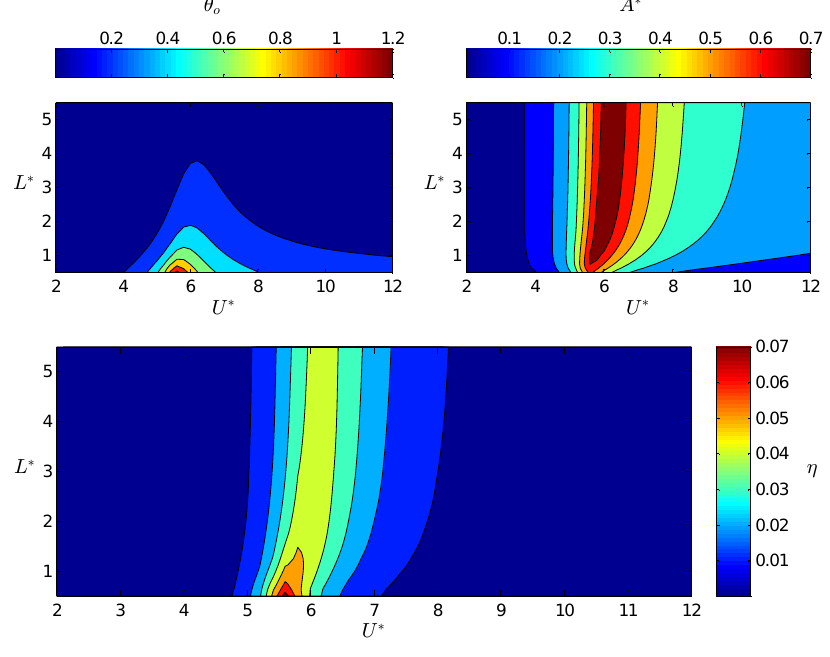
Figure 4. Contours of θ o and η as functions of L ∗ and U ∗ for m ∗ = 5 and ζ =